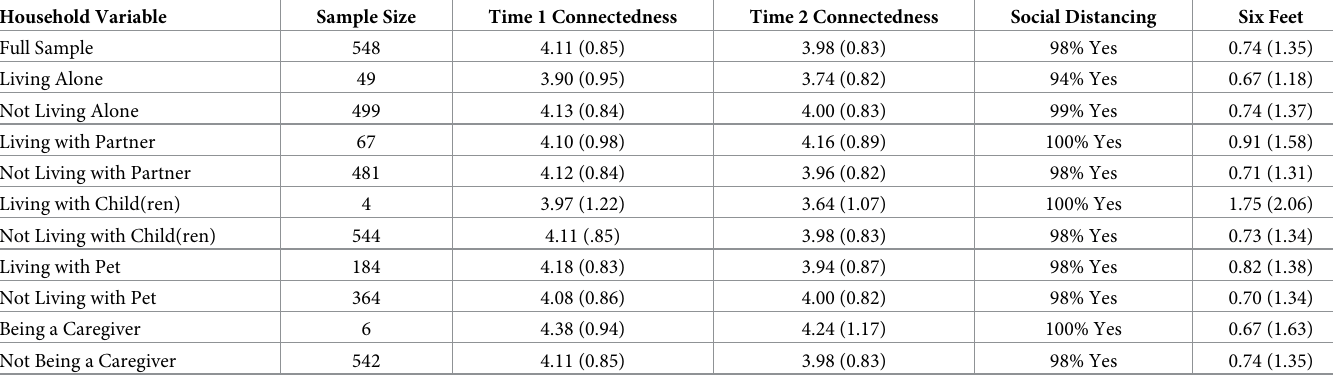
Table 2. Means and standard deviations for household size and composition (Study 1).